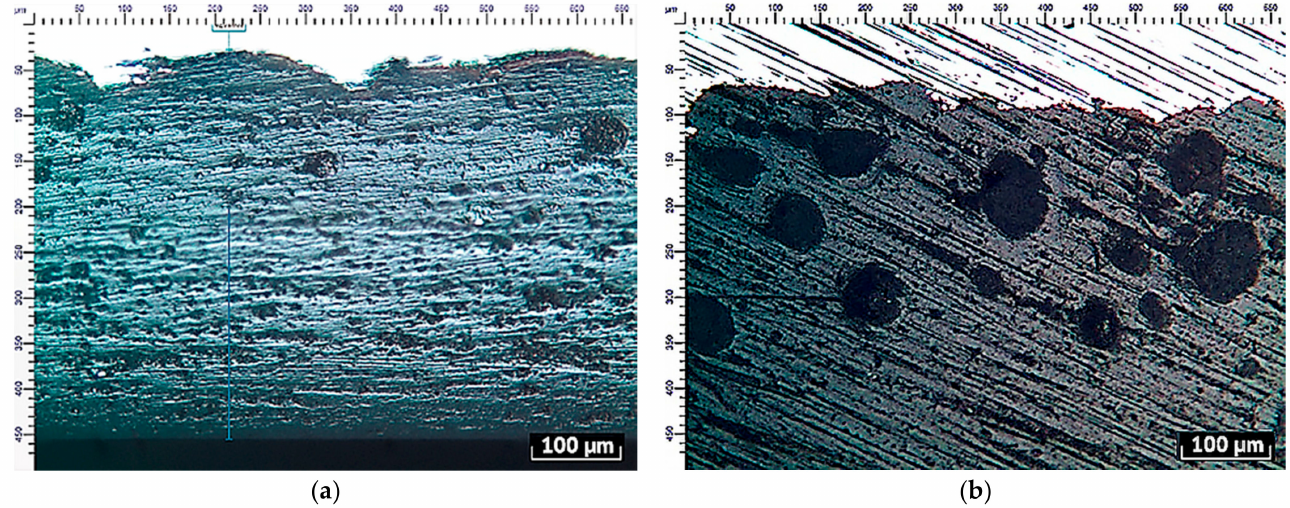
Figure 12. Coating structure after autoclave tests: ( a ) sample before testing, 100 × ; ( b ) sample after testing, 100 × .